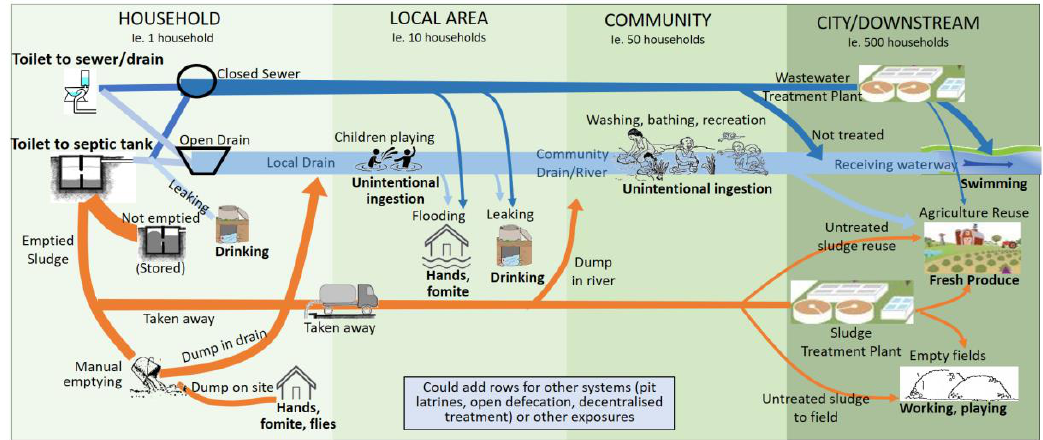
Figure 2. Example system diagram of flow divisions and related exposure points.